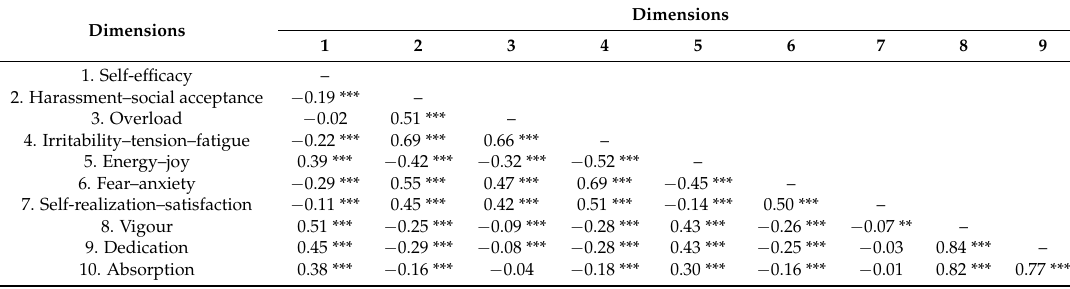
Table 1. Self-efficacy, perceived stress and engagement. Bivariate